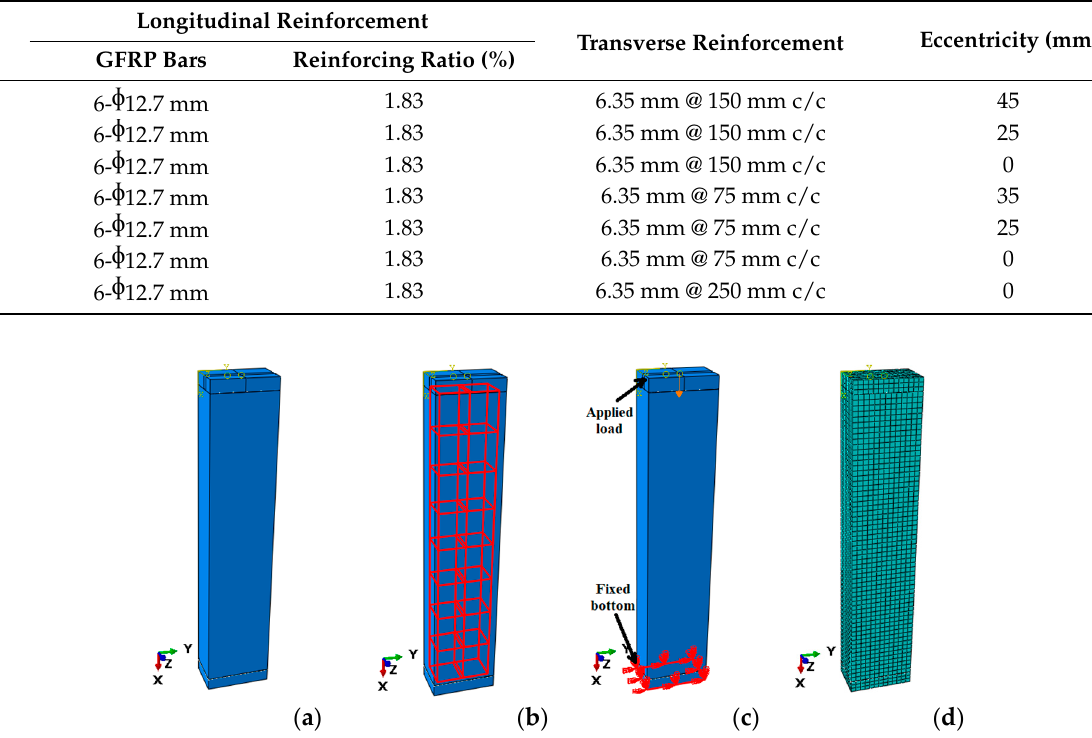
Figure 6. Finite element simulations of ( a ) geometry ( b ) interactions ( c ) support conditions ( d ) meshing of GFRP-RC specimens.